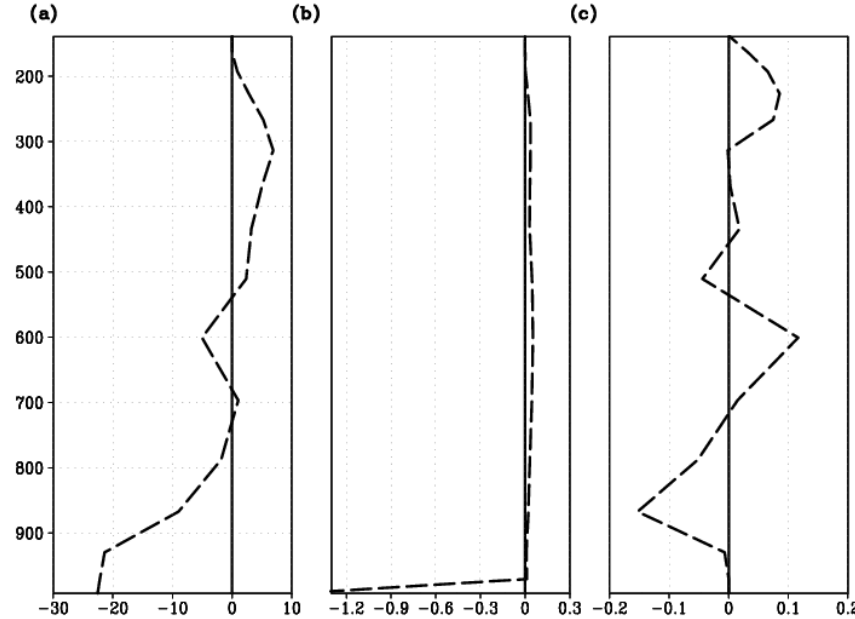
Fig. 6. Vertical profile of the area averaged (0 to 360 and 7 ◦ S to 7 ◦ N) time mean differences ( α =0.7– α =0.0). (a) Updraft mass flux (hPa/day) (b) Entrainment (c) Detrainment.